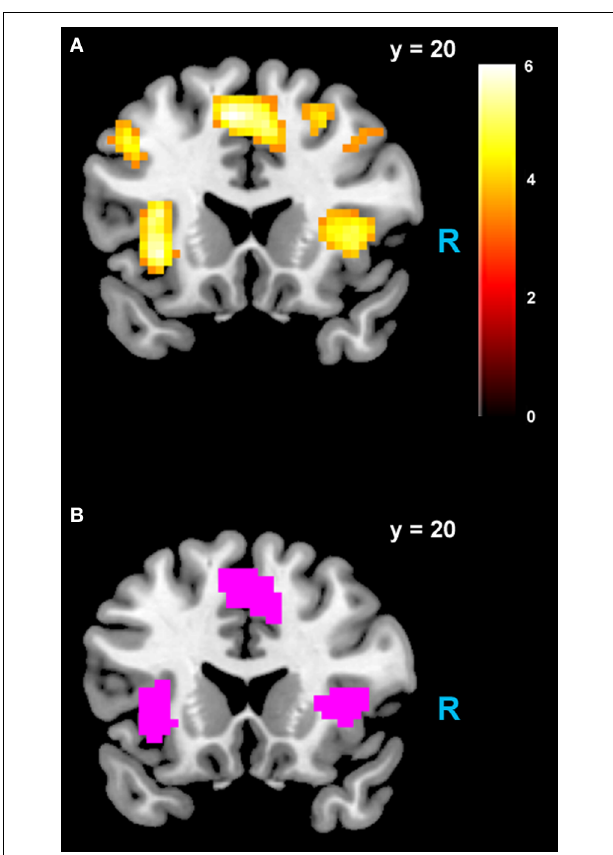
FIGURE 4 | Areas negatively correlated with the rdSV regressor from GLM-rdSV. (A) Regions of the dmPFC and AI where activity decreased as a function of rdSV ( p < 0 . 05 WBC). (B) Voxels in dmPFC and AI where responses to rdSV overlap with the meta-analyses results for regions that negatively correlated with subjective value at the time of choice in Bartra et al. (2013). All voxels shown in violet are significant in both